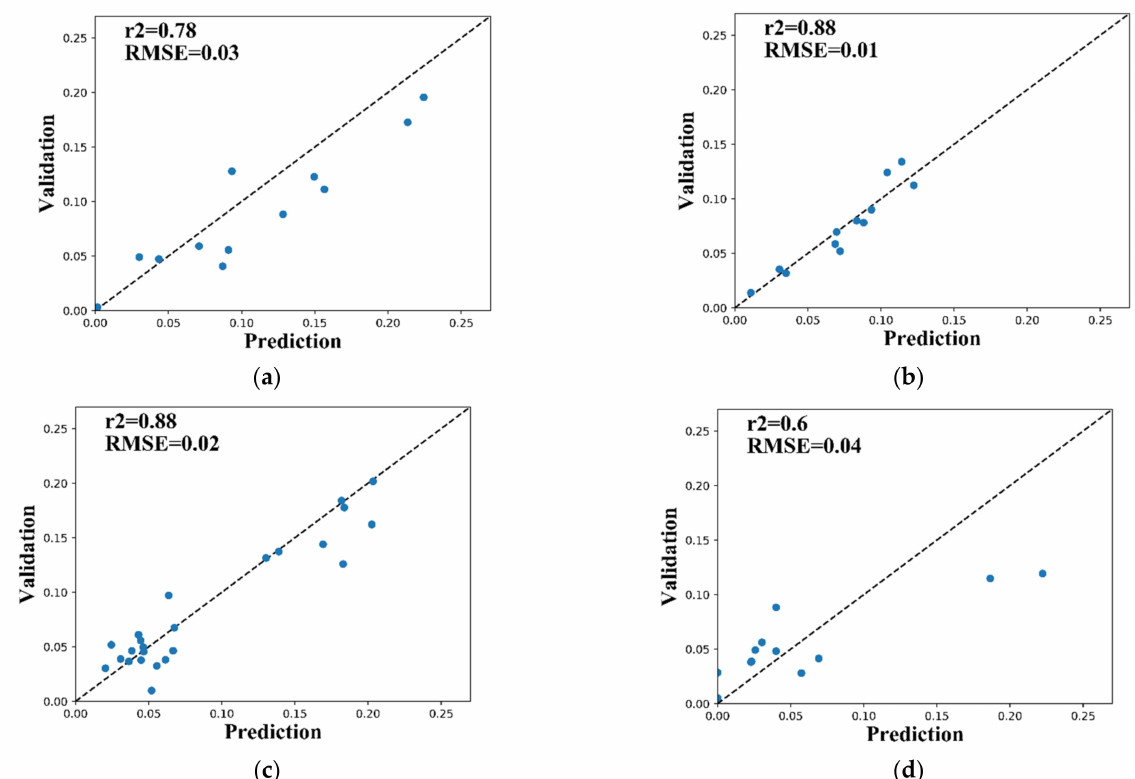
Figure 11. Accuracy of the intraday variation maps of population age structure in different UFRs: ( a ) open space, ( b ) public facilities, ( c ) residential, and ( d ) industry and commerce